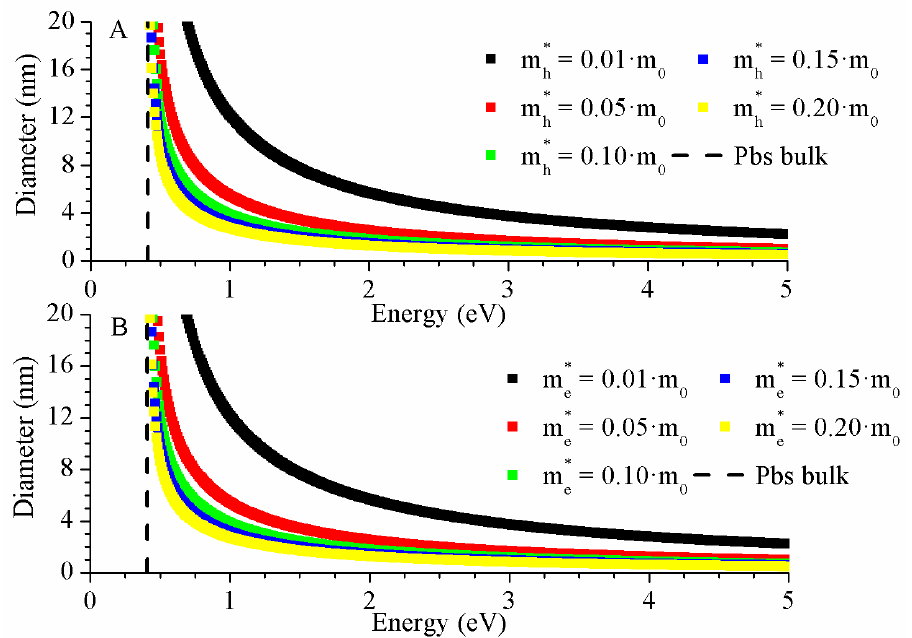
Figure 10. Estimated PbS NPs’ size by HBM model as a function of nanoparticle bandgap energy with ( A ) m h * and m e * ( B ) as parameters. The m h * oscillated between m h * = 0.01·m o and m h * = 0.20·m o and m e * oscillated between m e * = 0.01·m o and m h * = 0.20·m o , with E b remaining constant, E b = 0.41 eV.